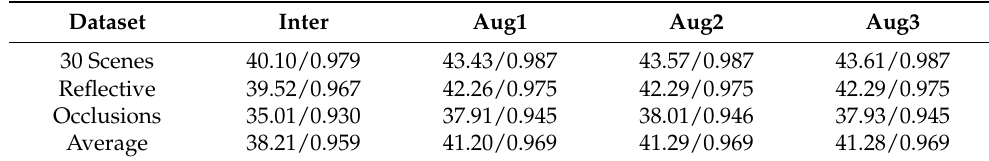
Table 6. In investigating the proposed architecture, including the angular augmentation block, we observe the best PSNR (dB) and SSIM values on task 2: 2 × 2 − 8 × 8 extrapolation